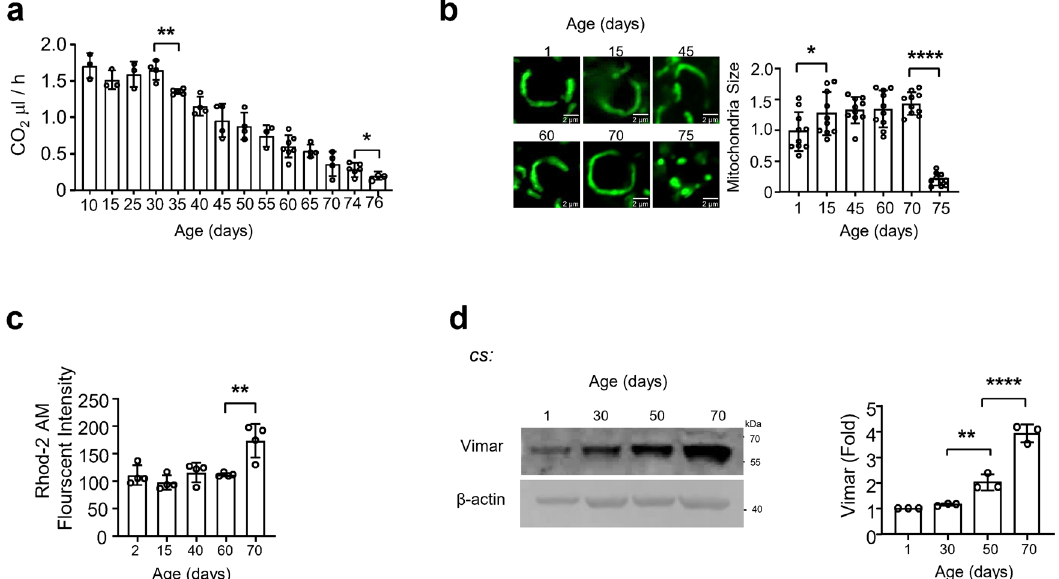
Fig. 1 Characterization of mitochondria-related functions in the life course of wild type fl ies. a The daily energy expenditure measured by CO2 production at different ages of the wild type CS adult fl ies. 15 fl ies were tested for each experiment. Trial N = 3 – 7. One-way ANOVA with Tukey ’ s post hoc test. ** P = 0.0008, * P = 0.0204. b Representative mitochondrial morphology in the brain around mushroom body. All mitochondrial images are Z-stacked throughout all fi gures. Mitochondria are labeled with UAS-mitoGFP , which is driven by Appl-Gal4 ( Appl > mitoGFP ). The age is indicated on each graph. Scale bars, 2 μ m. For all mitochondrial size and length quanti fi cation throughout all fi gures, individual mitochondrion was identi fi ed by ImageJ from a 3-D image convolution in a single neuron, with 10 neurons measured in each sample. The averaged mitochondrial size from 1 day-old is set as 1, and the relative ratios of the other ages are shown. Three area were averaged for each brain sample. Trial N = 10. One-way ANOVA with Tukey ’ s post hoc test. * P = 0.0136, **** P < 0.0001. c Mitochondrial calcium concentration ([Ca 2 + ] mito. ) change during aging. The intensity of Rhod2-AM indicates the relative level of [Ca 2 + ] mito . Trial N = 4. One-way ANOVA with Tukey ’ s post hoc test. ** P = 0.0026. d Representative micrograph of Vimar protein level during aging. β - actin is shown as the protein loading control from the same blot. Uncropped blots are shown in Supplementary Fig. 7. The band intensity of 1 day-old brain sample is set as 1, and the relative ratios of the other ages are shown. Trial N = 3. Error bars are mean ± SE. One-way ANOVA with Tukey ’ s post hoc test. ** P = 0.0091, **** P <